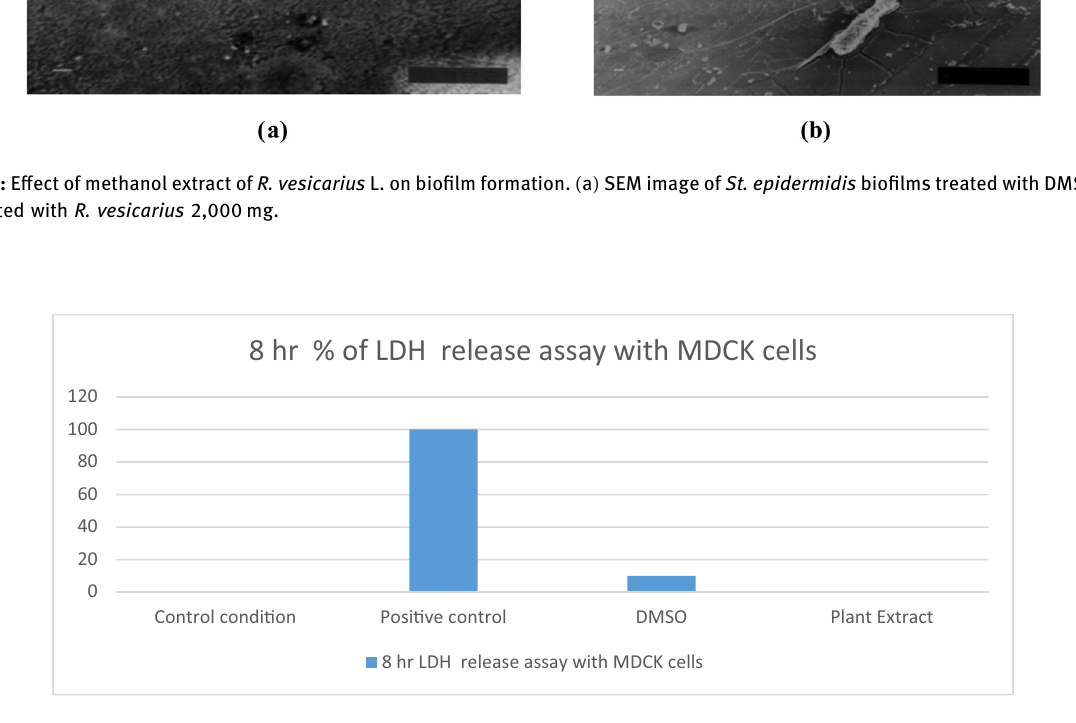
Figure 4: The percentage of LDH release with plant extract, control, DMSO, and positive control after 8 h incubation with MDCK